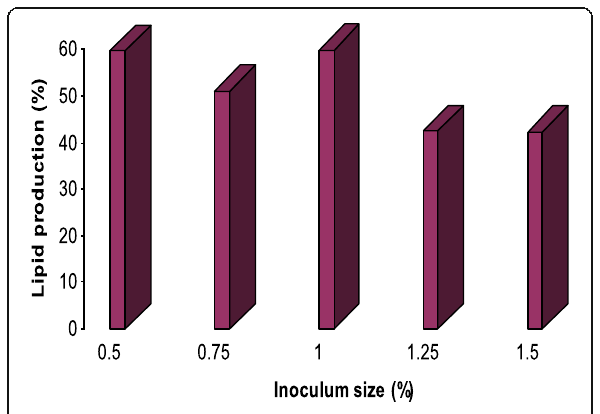
Fig. 6 Effect of inoculum size on F. oxysporum NRC 2017 lipid production